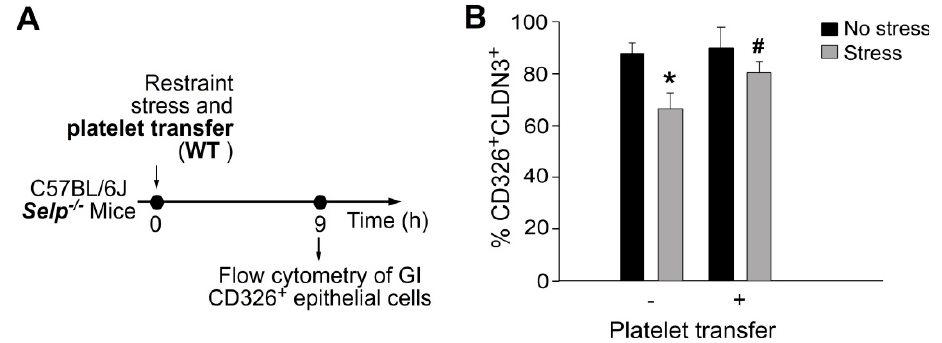
Figure 7. Stress-induced suppression of CLDN3 expression in GI CD326 epithelial cells was ame- liorated by platelet transfer in mice. ( A ) Experiment outline of restraint stress mouse model. ( B ) Flow cytometry analysis of CD326 + CLDN3 + epithelial cells from Selp − / − mice with or without stress, and with or without wild-type (WT) platelet transfer. CD326: epithelial cell marker; CLDN3: tight junction protein. * p < 0.05 vs. no stress groups; # p < 0.05 vs. without platelet transfer groups. n = 6 (three experiments with total six mice per group).